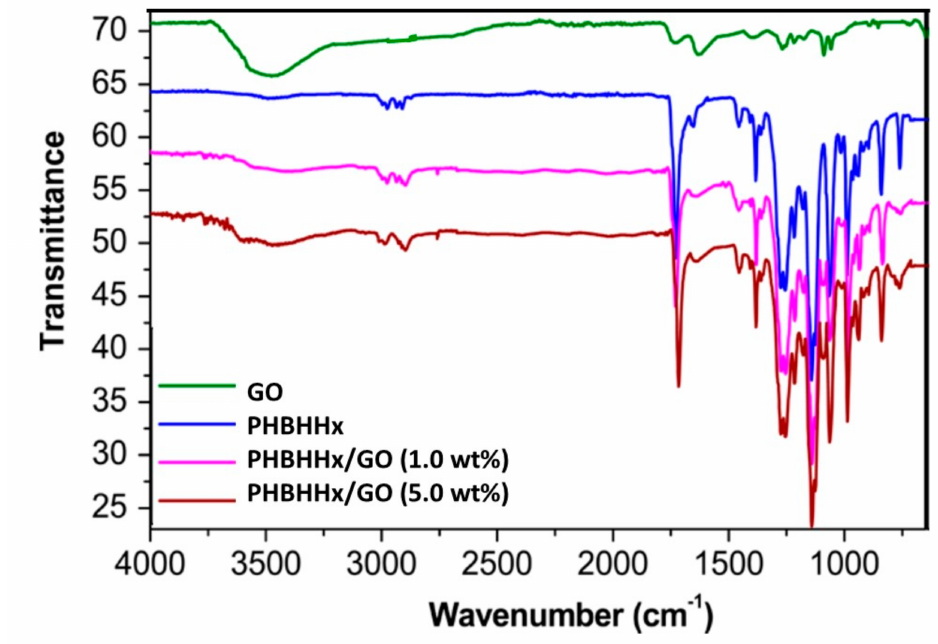
Figure 3. FTIR spectra of PHBHHx, GO and the nanocomposites with 1.0 and 5.0 wt%